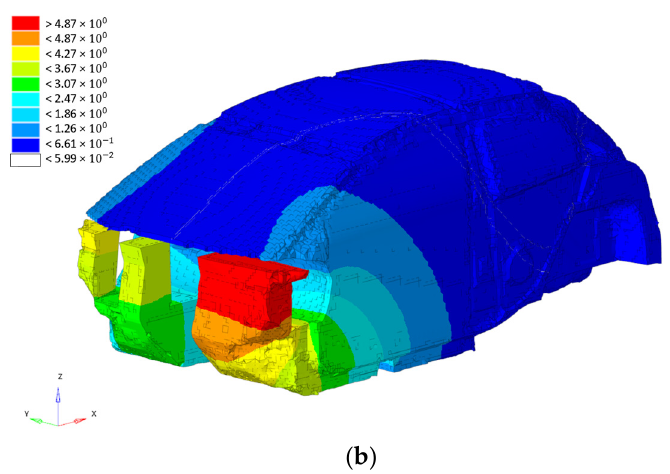
Figure 30. First two cavity modes: longitudinal global mode ( a ); local mode ( b ).